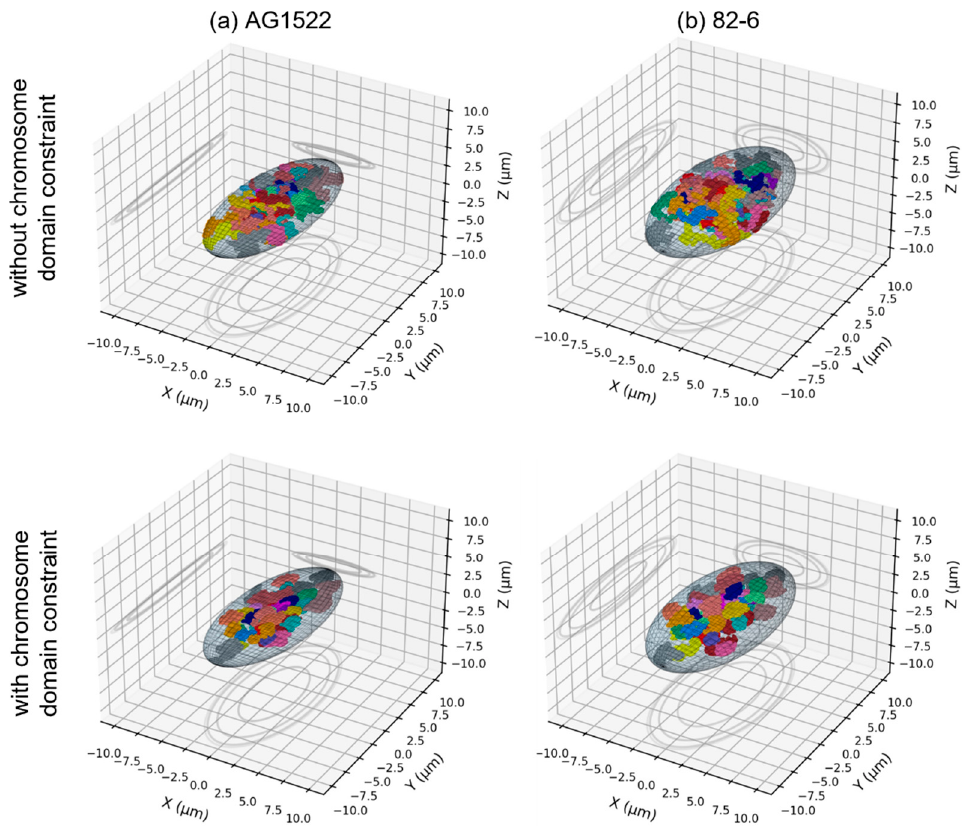
Figure 2. 3D distribution of the 46 chromosomes within ellipsoidal nuclei representing ( a ) AG1522 human fibroblast [32] and ( b ) 82-6 fibroblast [53,54] grown on a substrate (adherent cell). In the top row, the chromosomes are not constrained to be within their domain, while they are in the bottom row.